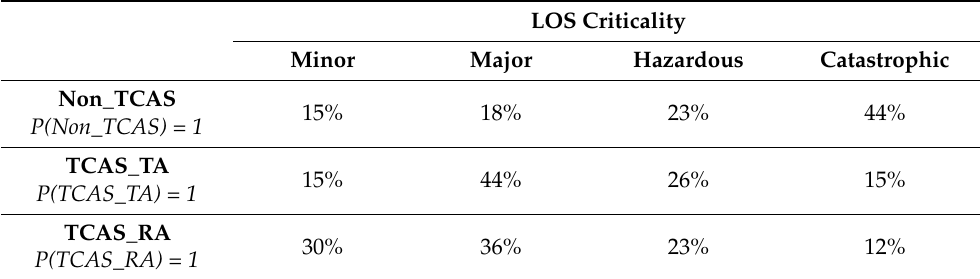
Table 11. LOS Criticality probabilities related to TCAS